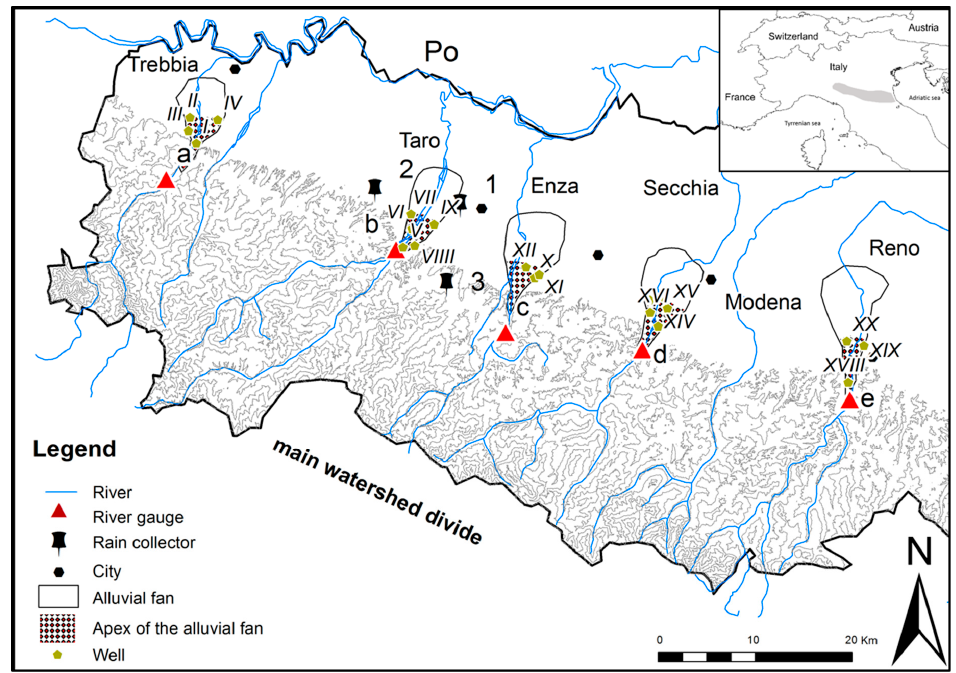
Figure 1. Sketch map of the five alluvial fans considered in this study and related to rivers Trebbia, Taro, Enza, Secchia and Reno along with locations in which groundwater (wells with roman letters from I to XX), precipitation (rain gauges numbered from 1 to 3) and surficial (rivers with letters from a to e) water samplings have been carried out by previous study.